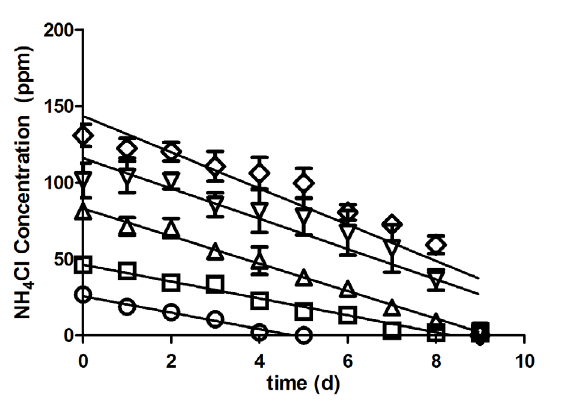
Figure 2: Specific growth rate of C. vulgaris growing at different N-NH concentrations 3